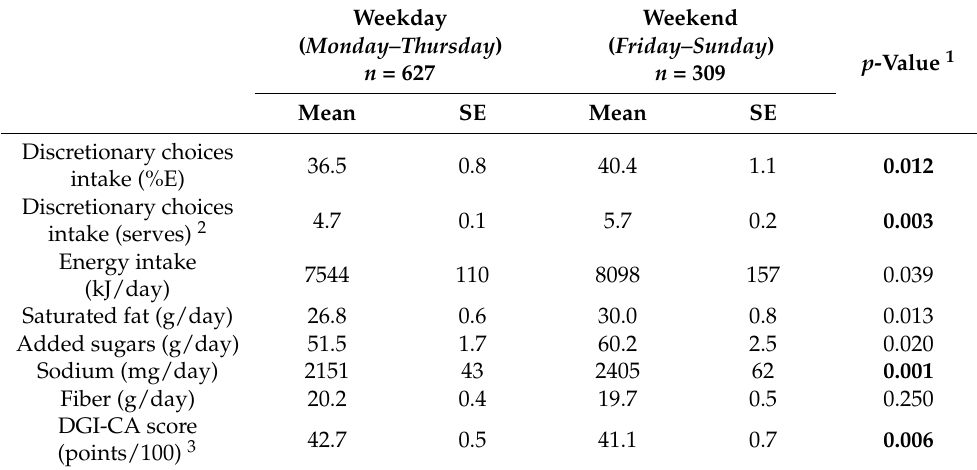
Table 3. Dietary intake of Australian primary school children (5–11 yo) on weekdays (Monday– Thursday) versus weekend days (Friday–Sunday).